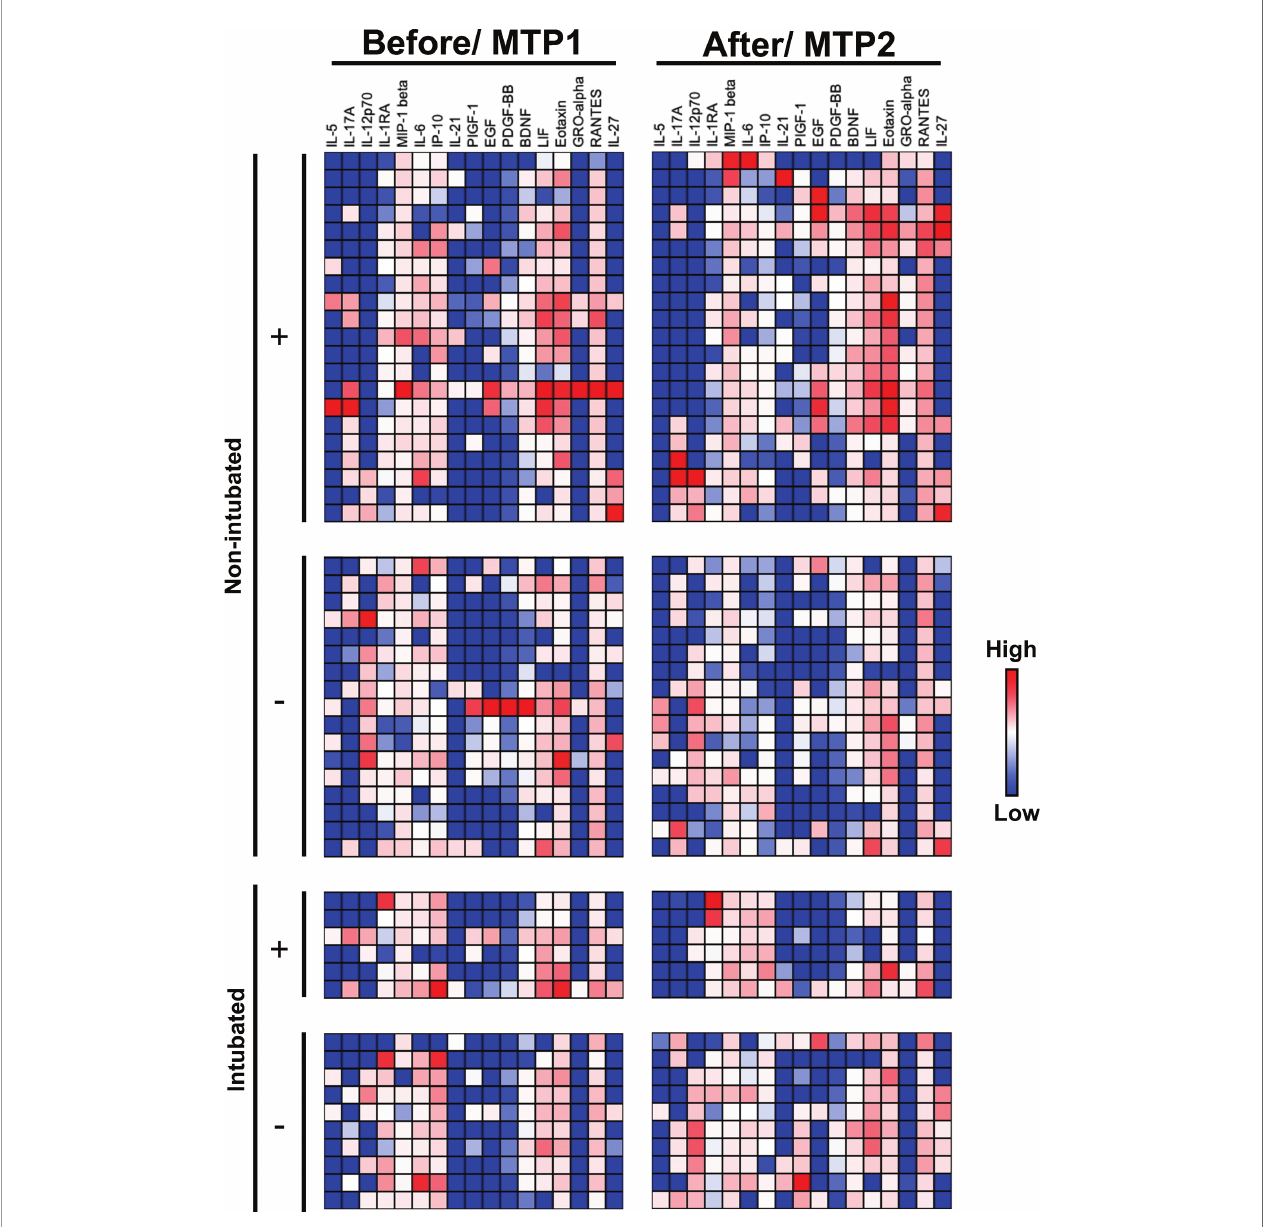
measured before [median 9 and 7 days post-illness onset (PIO)] and one week (median 16 and 13 days PIO) after RDV treatment for responders and non- responders, respectively. Immune mediator levels in timepoint matched (MTP) plasmas samples from non-intubated (n = 17, median 10 and 16 days PIO) or intubated (n = 10, median 6 and 12 days PIO) COVID-19 patients were also quanti fi ed for controls. RDV-treated and control patients are indicated with + and -, respectively. Each color represents the relative concentration of a particular analyte (blue = low concentration; red = high concentration). Each row represents one patient. Patient samples with concentration out of measurement range are presented as the value of Limit of Quanti fi cation